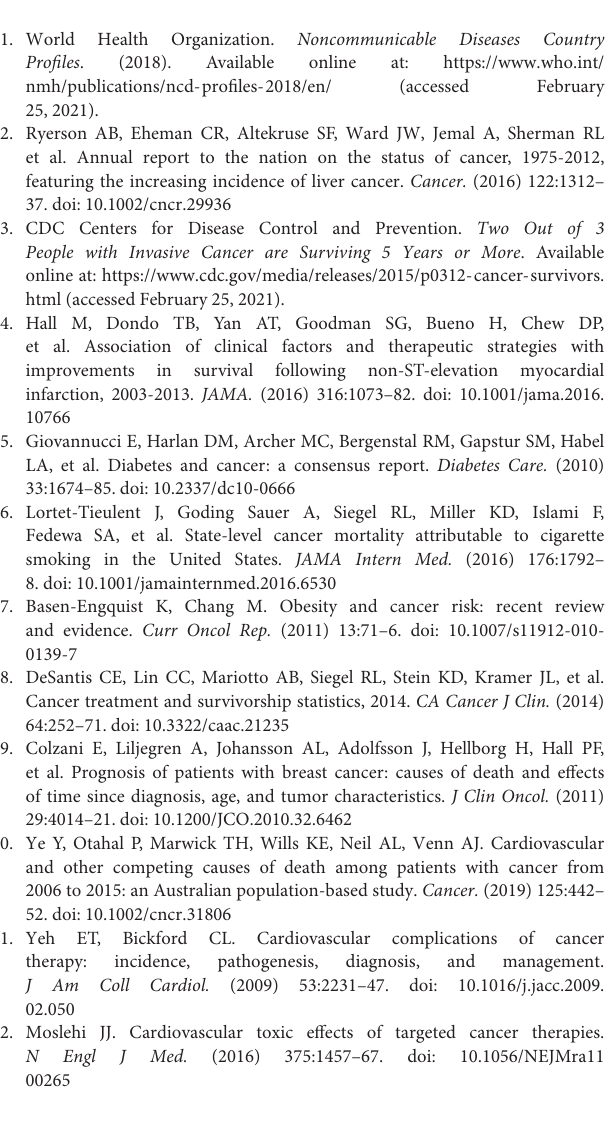
BMI, body mass index; CI, confidence interval; MI, myocardial infarction; PCI, percutaneous coronary intervention; STEMI, ST segment elevation myocardial infarction. Supplementary Figure S3 | Subgroup stratified analysis of MACCE among AMI patients with and without cancer. AMI, acute myocardial infarction; BMI, body mass index; CI, confidence interval; MACCE, major adverse cardiovascular and cerebrovascular events; MI, myocardial infarction; PCI, percutaneous coronary intervention; STEMI, ST segment elevation myocardial infarction. Supplementary Table S1 | Pathological types in the 150 patients with cancer. Supplementary Table S2 | Cumulative incidence of outcomes among AMI patients with and without cancer. Supplementary Table S3 | Cumulative incidence of 1-year outcomes among AMI patients with and without